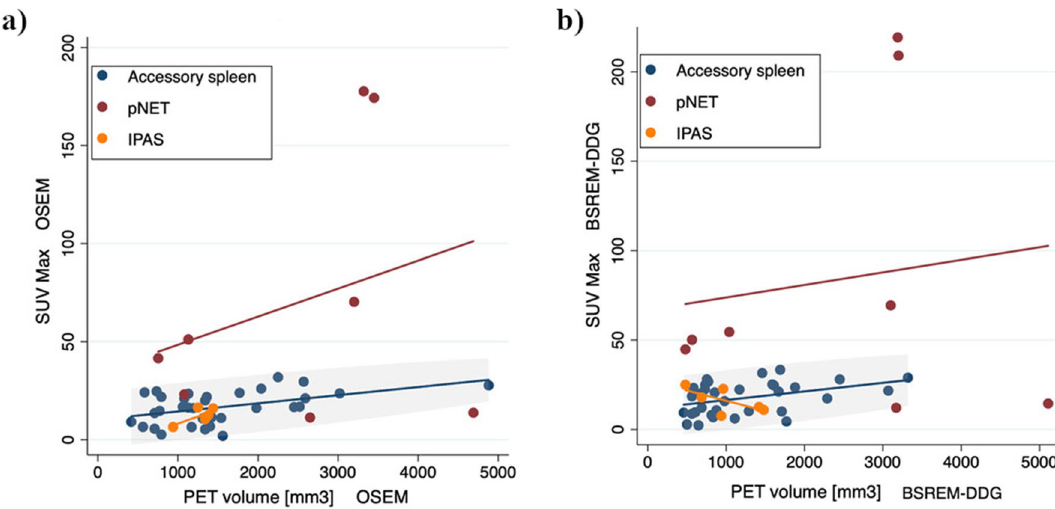
Figure 5. Scatter plots showing the relationship between SUVmax and PET volume of accessory spleens, IPAS and pNETs in OSEM ( a ) and BSREM-DDG ( b ), respectively, in the sub-cohort of patients retrospectively acquired (42 accessory spleens, 6 IPAS and 8 pNET).